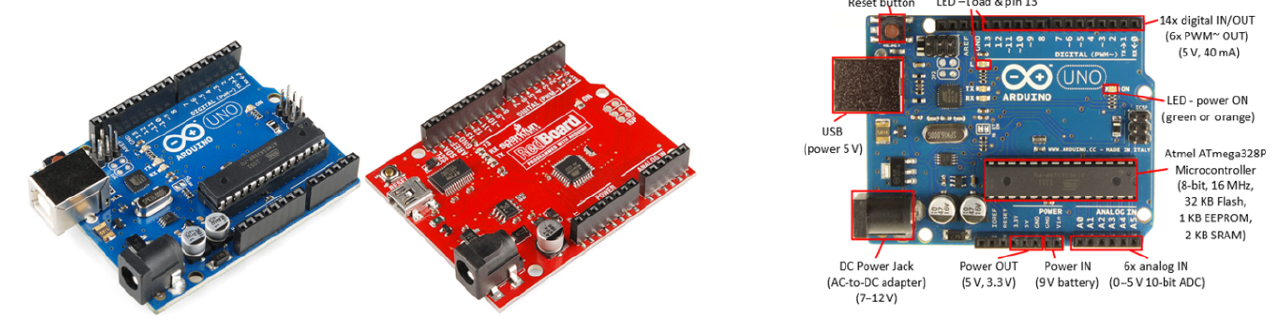
Figure 1. Arduino Uno and Redboard microcontrollers with pin diagram.